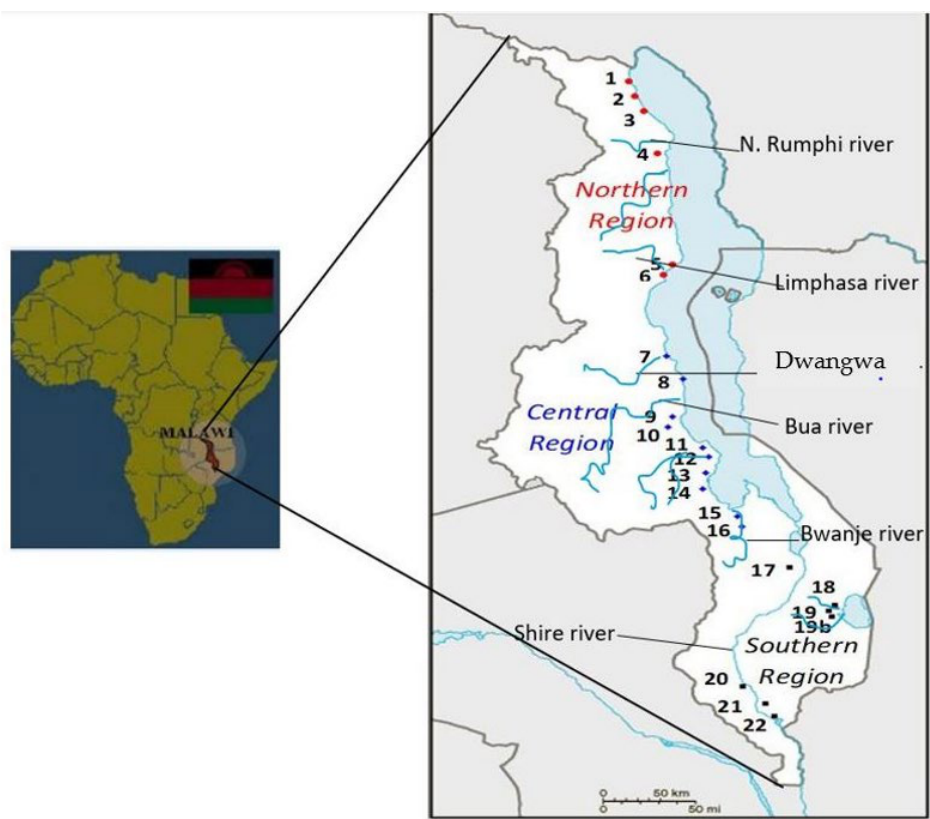
Figure 1. Map of Malawi showing sampled sites in three geographical regional of Malawi as adapted from Mlangeni et al. [29]. The sampled sites are Lufiliya (LFY; #1 and 2), Hara (HAR; #3), North Rumphi (NRU; #4), Limphasa (LPH; #5 and 6), Nkhotakota (KK; #7–9), Salima (SAL; #10, 12–14), Lifuwu (LFW; #11), Bwanje (BWJ; #15 and 16), Balaka (BLK; #17), Domasi (DOM; #18), Khanda (KHA; #19 and 19b), Kasinthula (KAS; #20), and Nkhate (NKH; #21 and 22). Red, Blue and black sites on the map are sites located in Northern, Central and Southern regions respectively. For soil pH, soils were also grouped into soil pH ranges: of equal to or less than 6.0 (soil pH ≤ 6.0; n = 35); between 6.00 and 7.0 (6.0 < soil pH < 7.0; n = 12); and equal to or greater than 7.00 (soil pH ≥ 7.0; n = 11). Sites characterized by soil pH ≥ 7.0 were Bwanje (BWJ), Domasi (DOM), Kasinthula (KAS), and Lifuwu (LFW); sites characterized by soil pH ≤ 6.0 were Limphasa (LPH), Hara (HAR), and parts of Nkhotakota (KK); and sites characterized by soil pH between 6.00 and 7.0 were Salima (SA), Lufiliya (LFY), and Bwanje (BWJ)